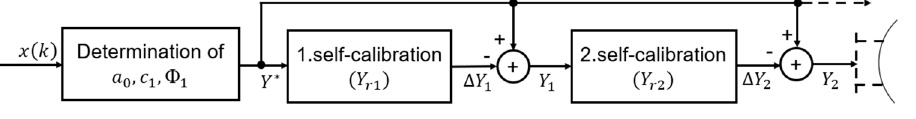
Figure 4. Principle of the iterative self-correction algorithm of the coefficients a 0 , C 1 , and Φ 1 per- formed twice in a sequence [13].